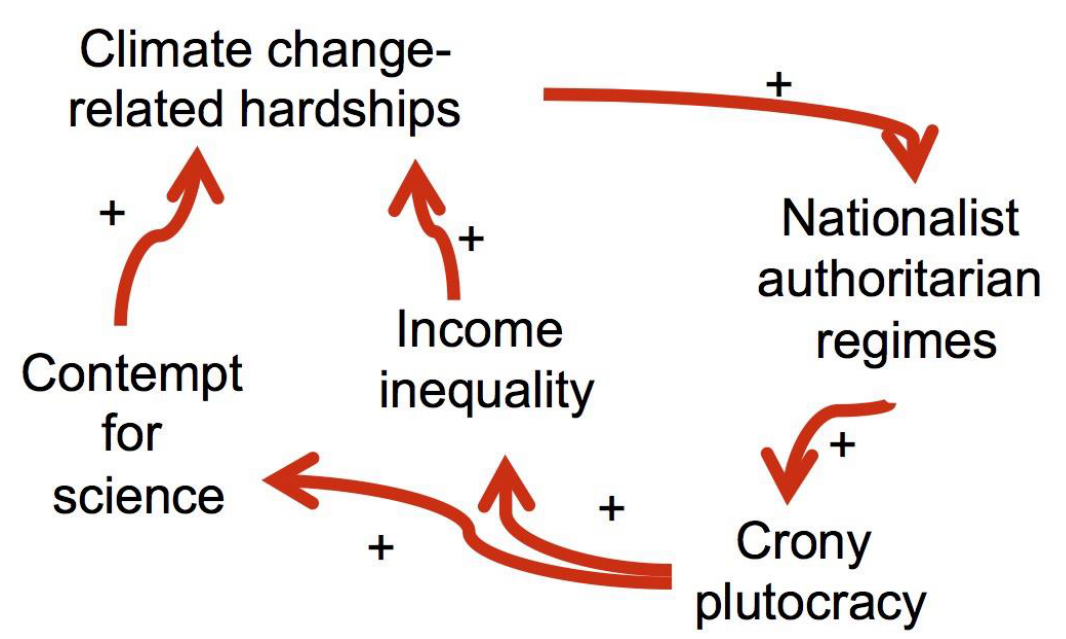
Figure 1. Influence diagram linking politics, economics, and science.